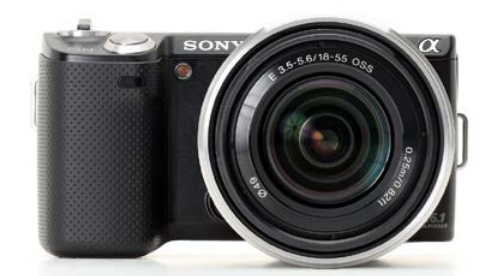
Figure 2. Sony Nex-5 RGB camera [sony.pl]